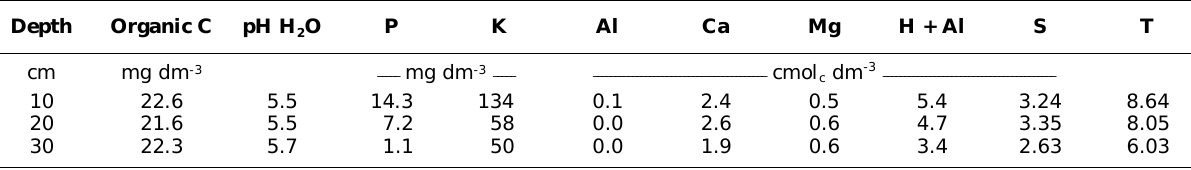
Table 3. Chemical characteristics of soil at 10, 20 and 30 cm depth